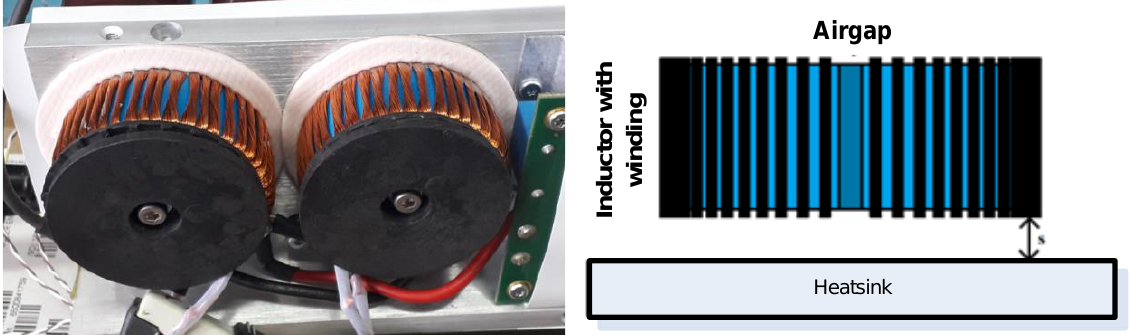
Figure 16. Practical realization of PFC inductor v2 for experimental verifications ( left ) and demon- stration of the evaluation of the inductance value stability ( right ).